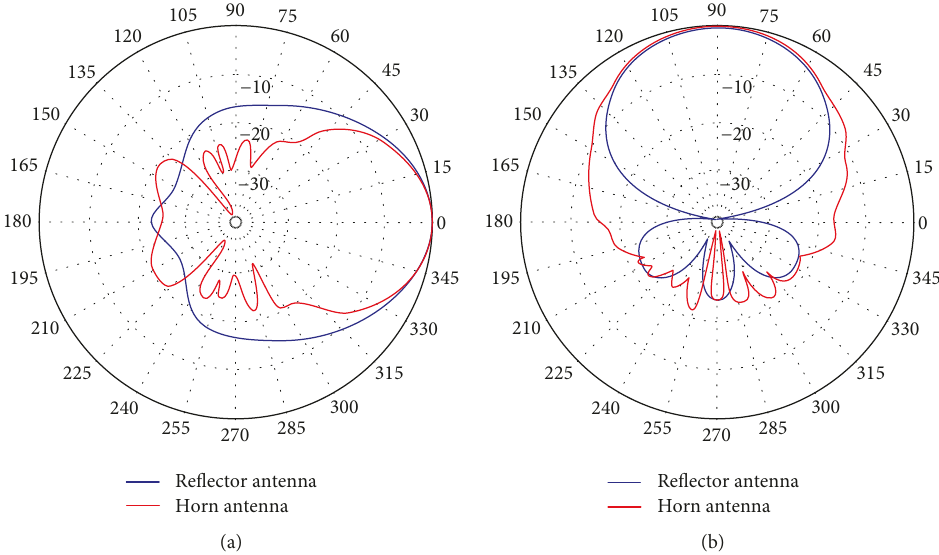
Figure 6: Radiation pattern of horn antenna (measured) and corner re fl ector antenna (simulated in XFdtd), normalized to a maximum value of 9.5 dBi with vertical polarization: (a) horizontal plane; (b) vertical plane.